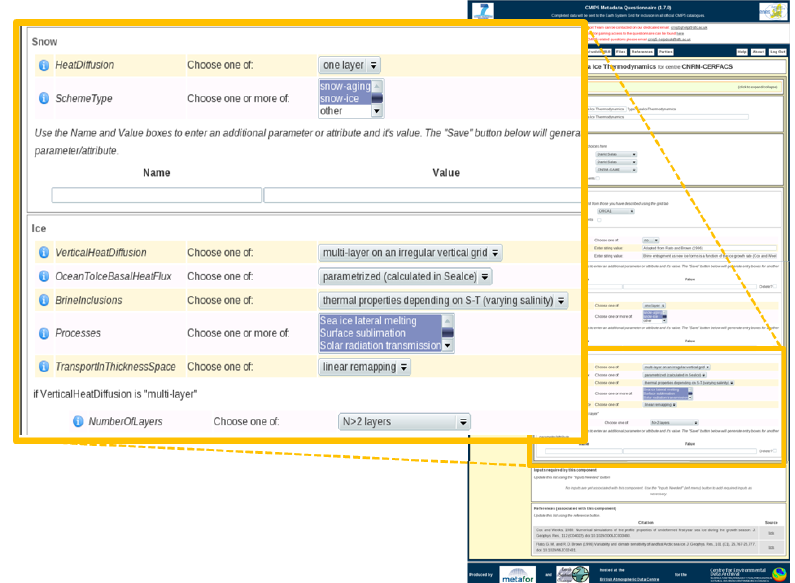
Fig. 7b. Continuing Fig. 7a. Each model component mindmap provides the content of the corresponding questionnaire page, and parameter groups in the component mindmap determine the frames in the page; mindmap leaf parameters define the requested information lines in the frames; list of possible CV values for a given parameter forms the content of drop-down menus (enhanced in the